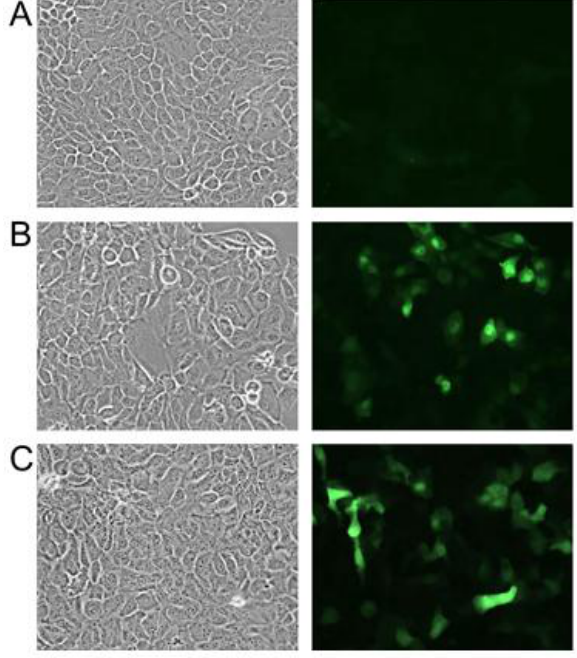
Figure 4. Fluorescence microscopy of HSP70B'-GFP sensor cells. Phase contrast images (left panels) and GFP fluorescence (right panels) of either untreated cells ( A ) or cells that were treated for 6 h with 25 µM CdCl ( B ) or 5 µM helenalin ( C 2